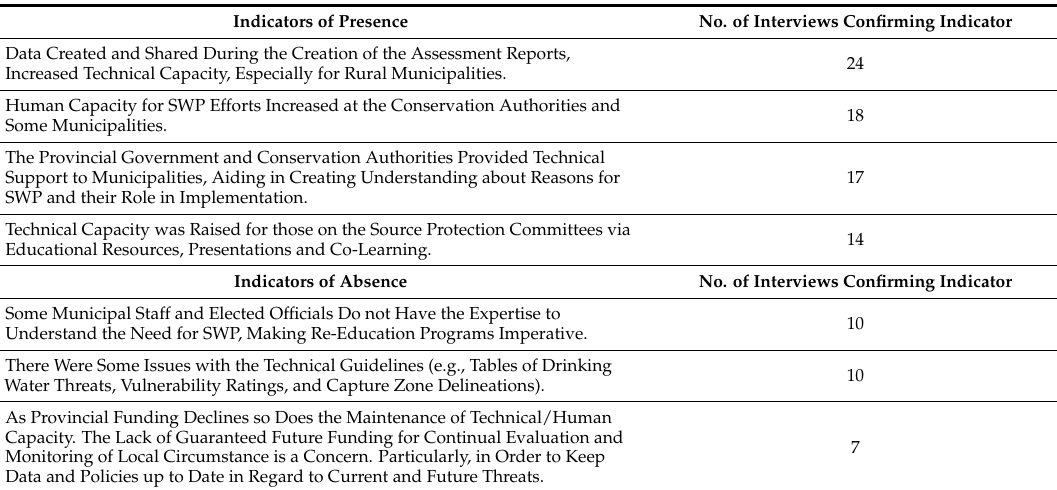
Table 7. Key Findings for Technical/Human